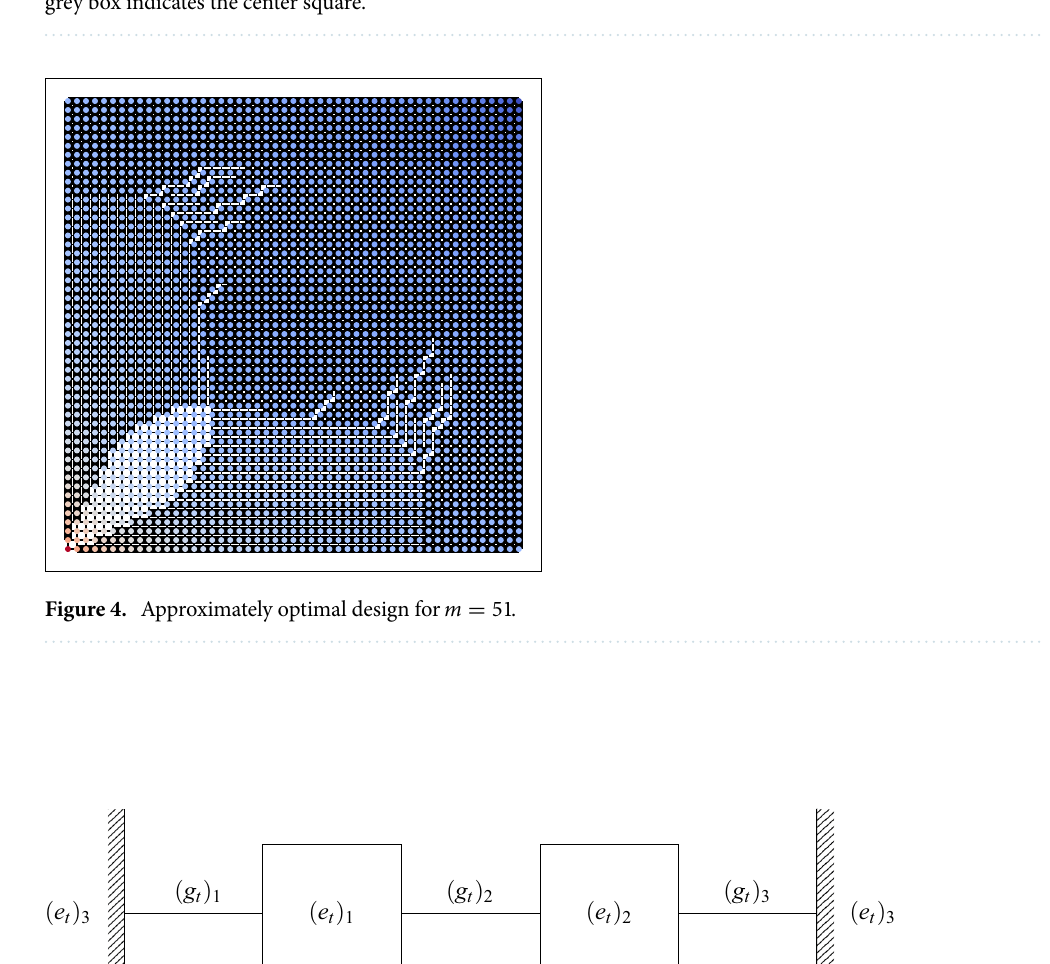
Figure 3. Approximately optimal design for m = 11 . Arrows indicate the direction of flow used for this design, colors indicate the temperature at each node, while edge thickness indicates the conductance at each edge. The grey box indicates the center square.